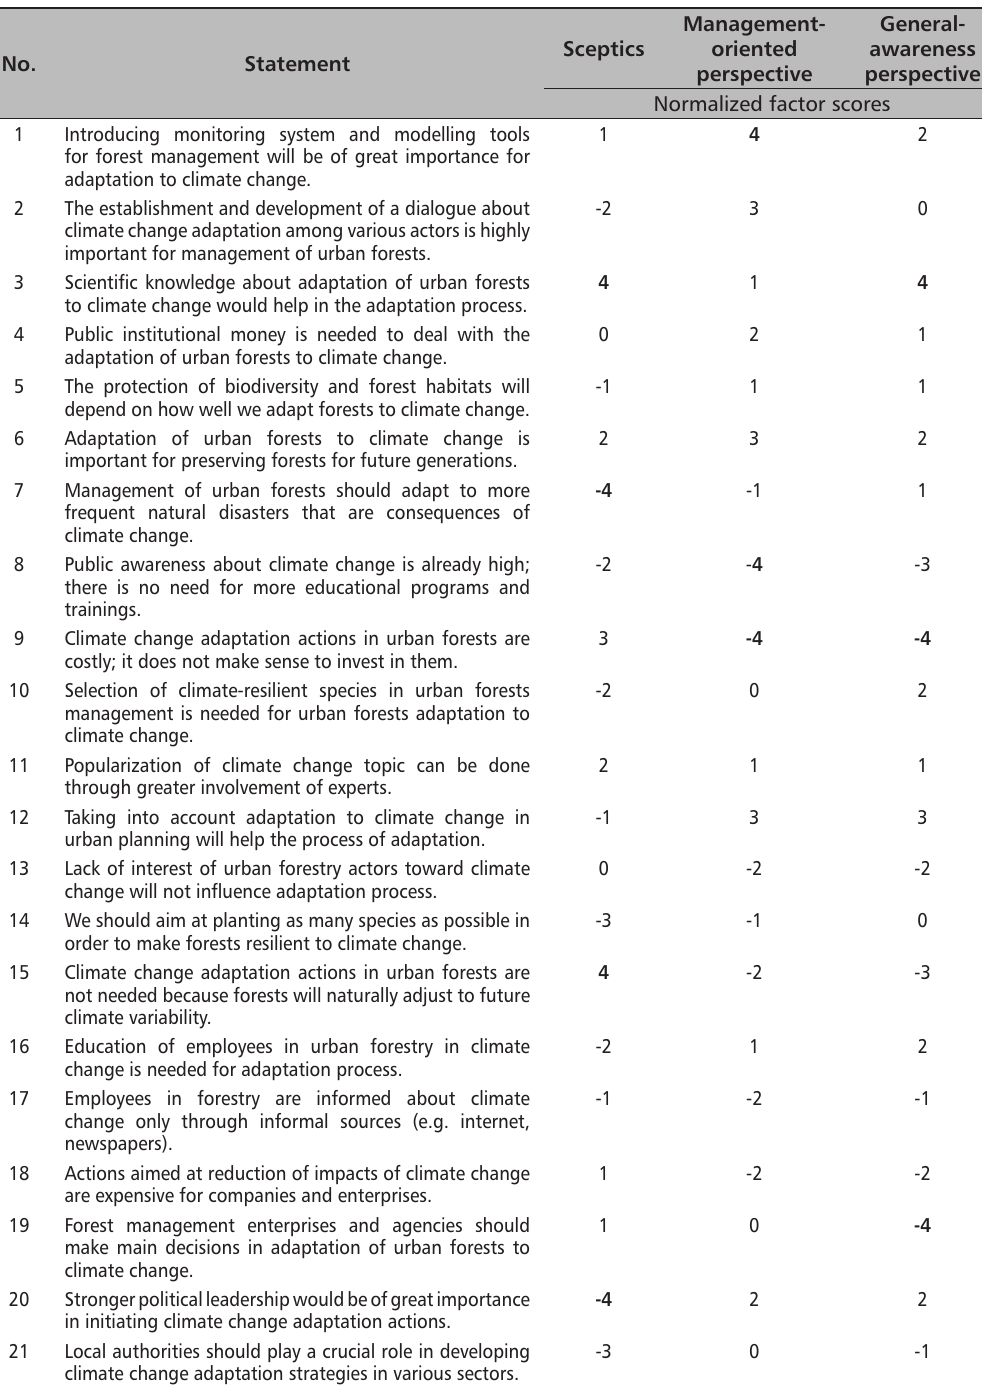
TABLE 2. List of statements used in Q-methodology with normalized factor scores for each statement and perspective